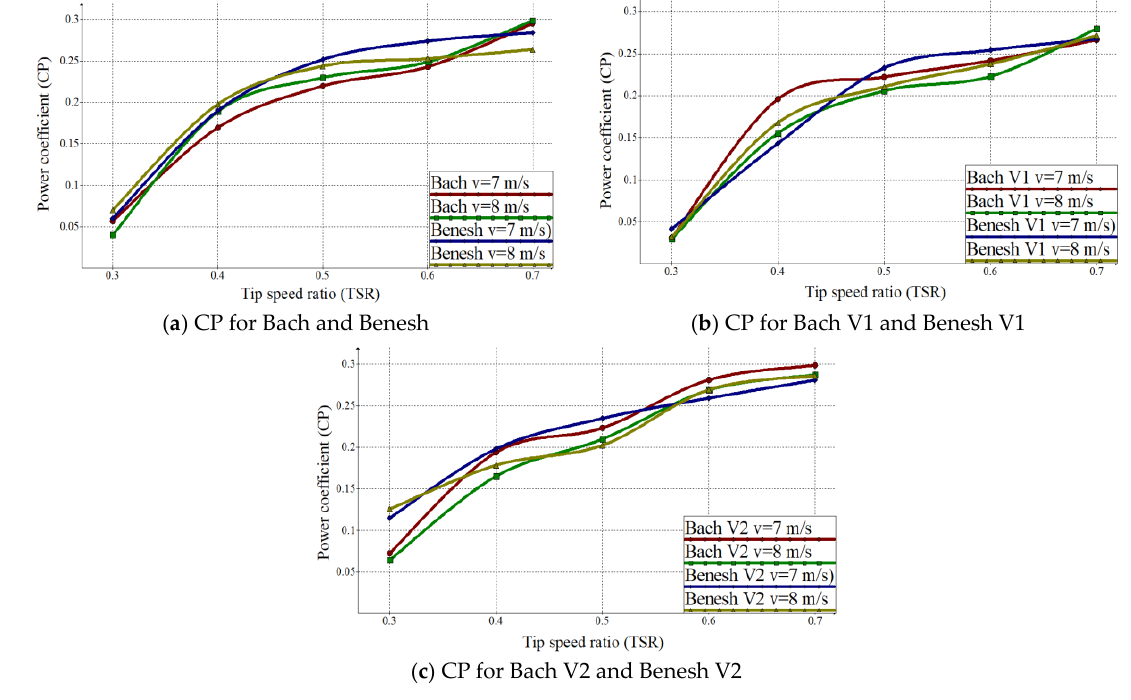
Figure 9. Power coefficient (CP) for analyzed rotor models. Figure 9. Power coe ffi cient (CP) for analyzed rotor